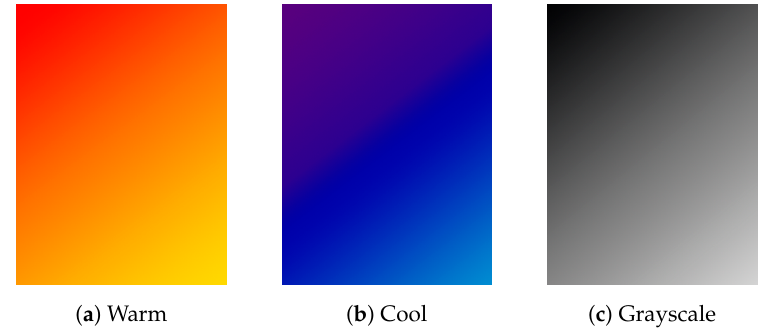
Figure 1. Levels for design factor “Color”.